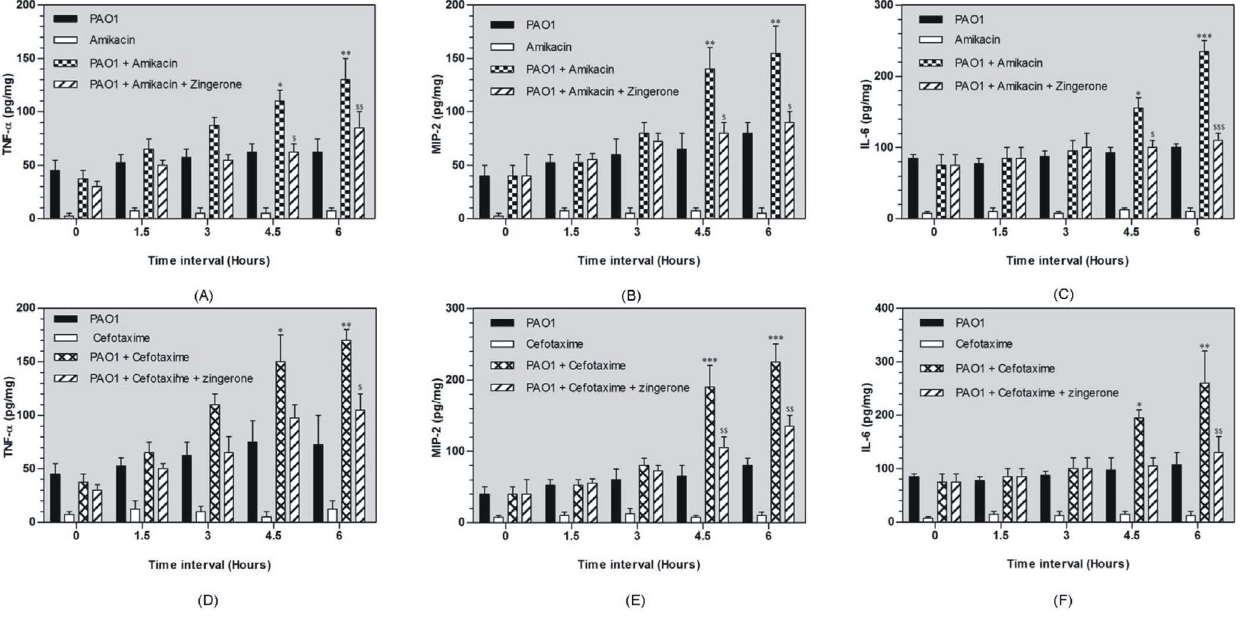
Figure 5. Effect of zingerone treatment on hepatic pro-inflammatory cytokine production (TNF- a 2 and IL-6) in liver homogenate against antibiotic mediated endotoxemia (cefotaxime Fig.5-A, B, C) and amikacin (Fig 5-D, E, E) ( $ , * p , 0.01, $$ , ** p , 0.01 and ***, $$$ p , 0.001).